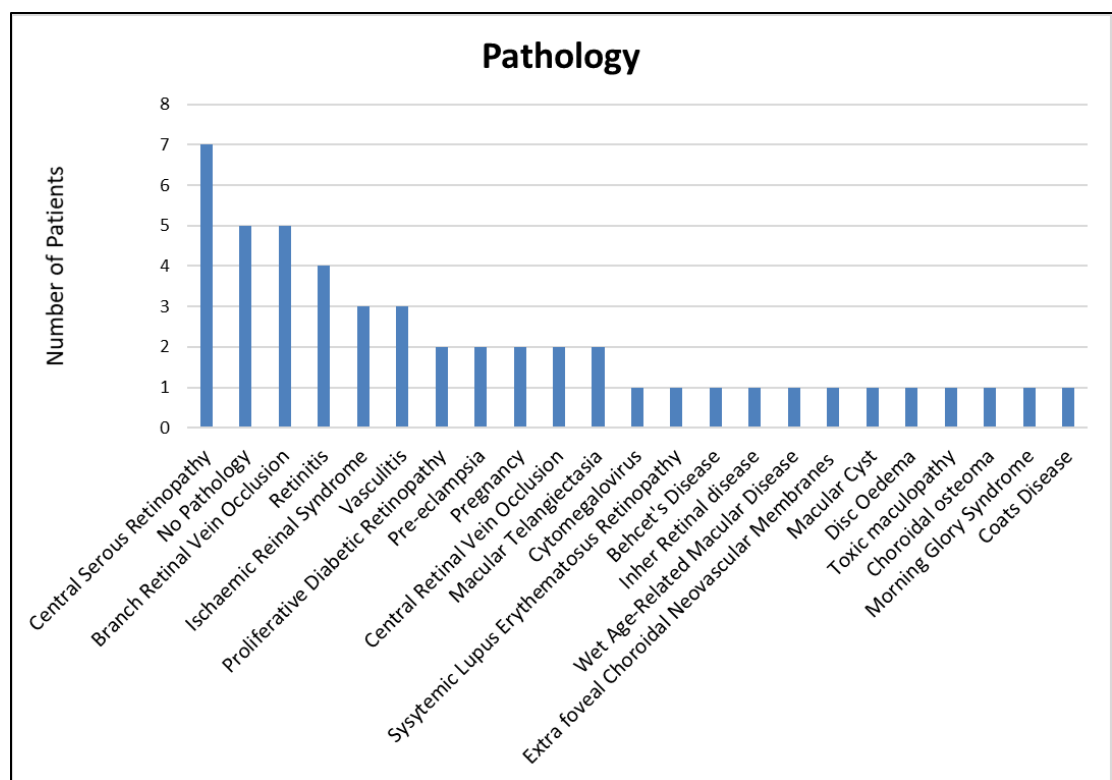
Figure 3. Pathology assessed in forty-nine 10 × 10 mm OCT-A1 scans.